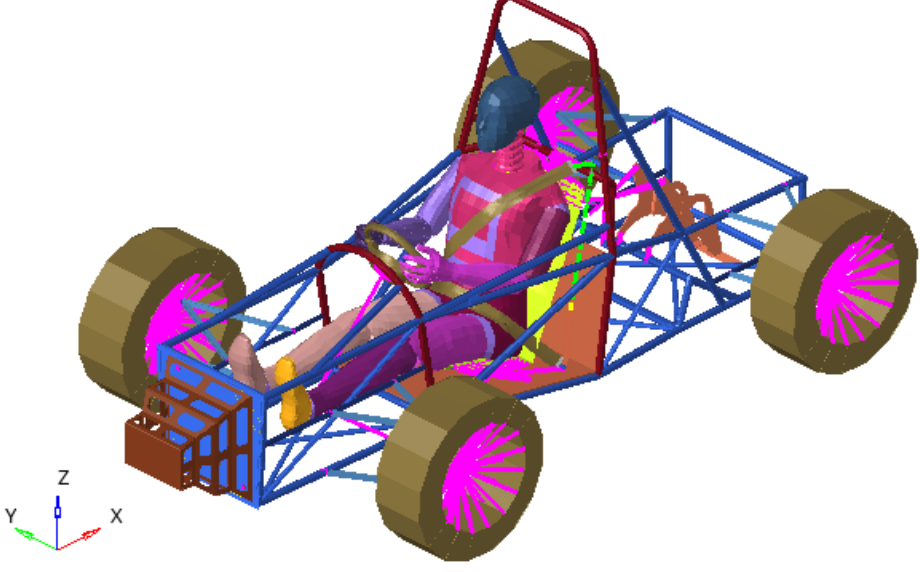
Figure 1. The car with a shock absorber and a seat belt. Aerial view.